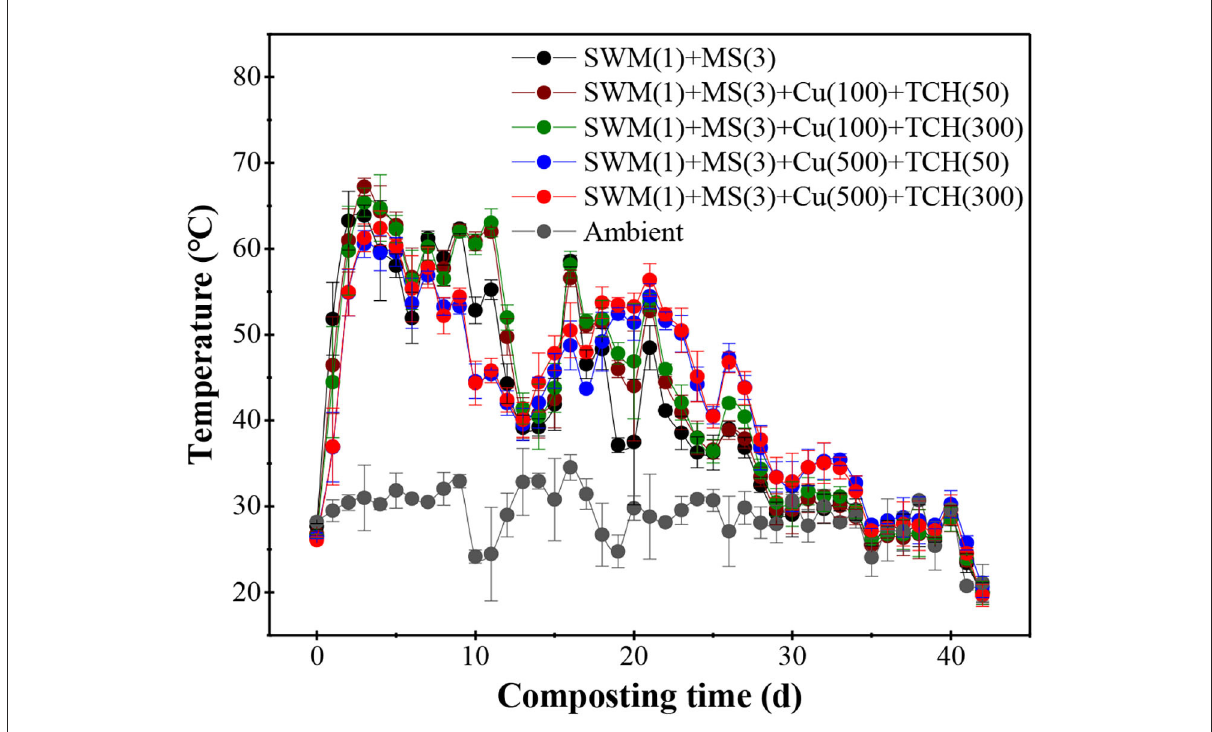
FIGURE1 Dynamic changes in the temperature during the composting